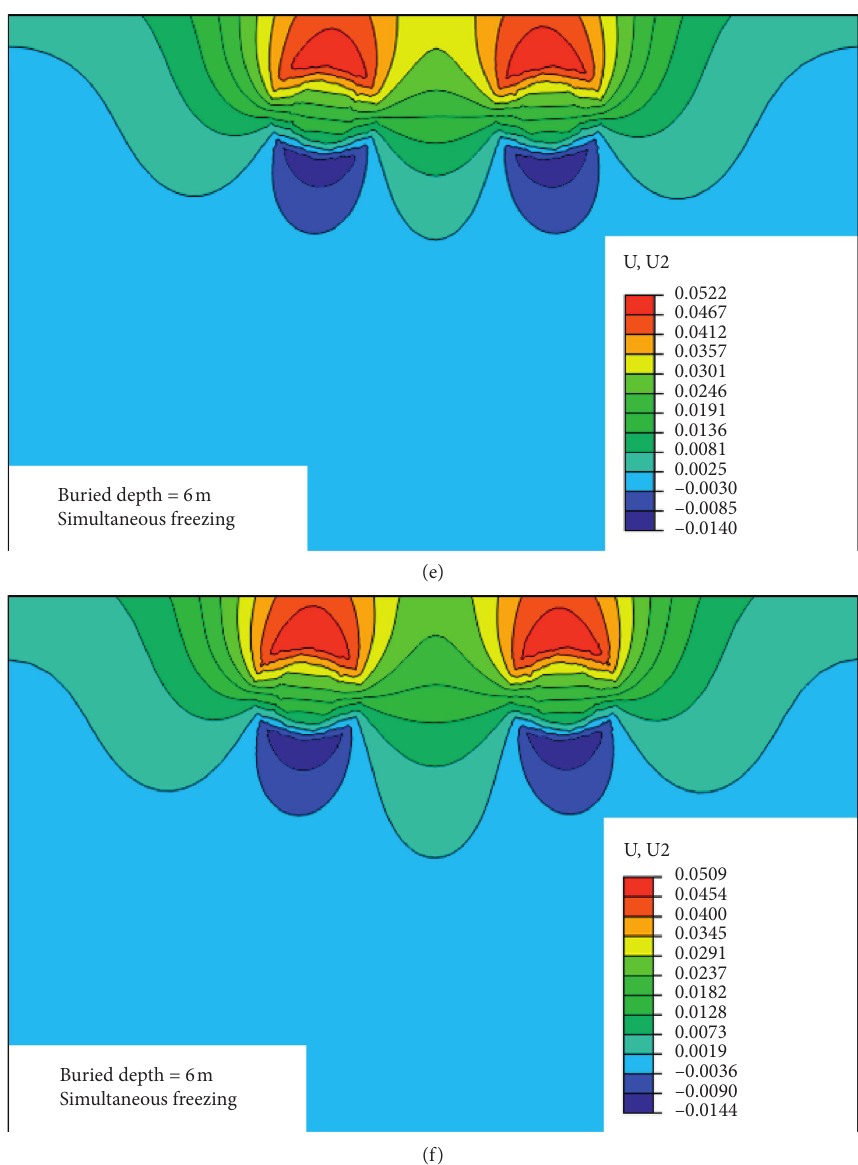
Figure 5: Vertical displacement field of the ground (unit: m). (a) 0.25D, (b) 1.00D, (c) 1.50D, (d) 2.00D, (e) 2.50D, and (f)